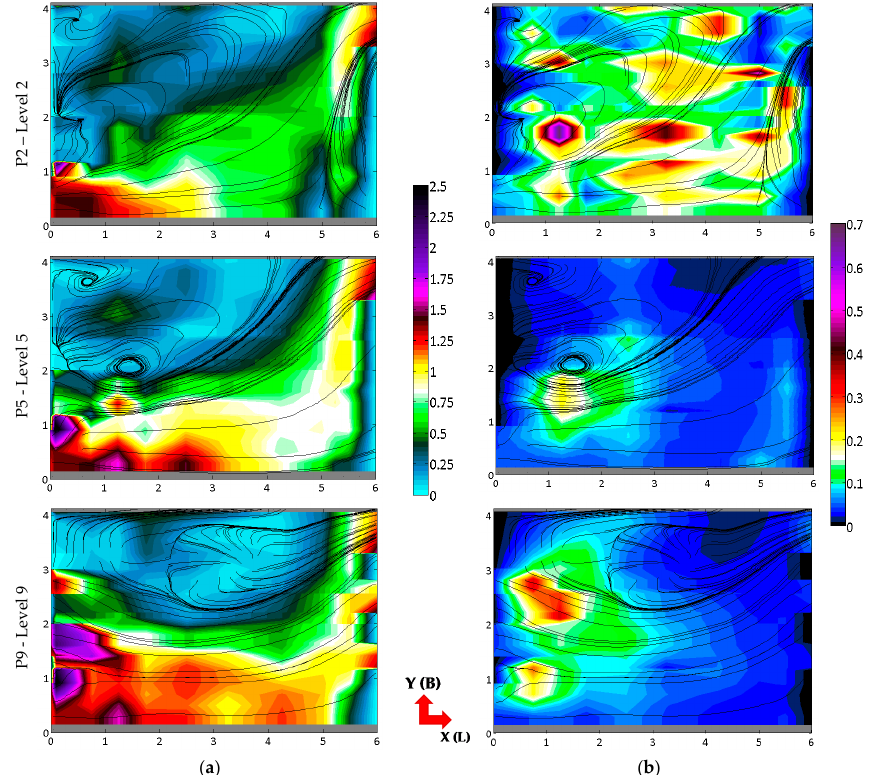
Figure 2. Characteristic sections at the actual scale. ( a ) Average flow velocities (m/s); ( b ) TKE (turbulent kinetic energy) (m 2 /s 2 ); dimensions on the axes (m). Model A.